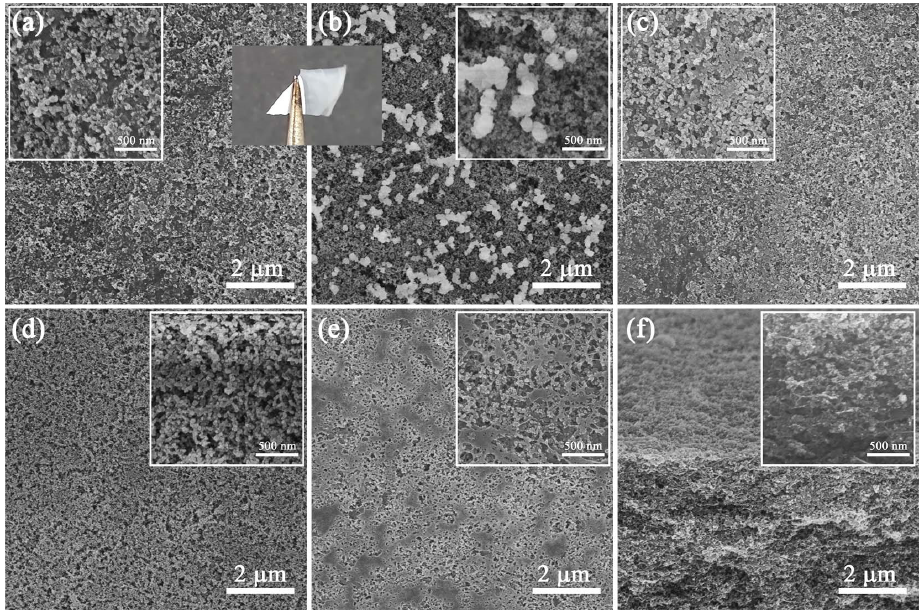
Figure 4. SEM images of D 6 + HS 150 films ( a ) before and ( b ) after combustion. SEM images of HS 150 D 6 films ( c ) before and ( d ) after combustion. SEM images of ( e ) bottom-section and ( f ) cross-section of HS 150 D 6 films.